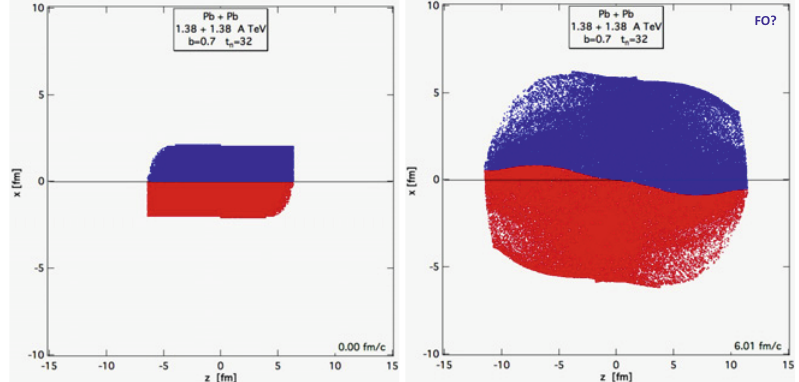
Figure 3. The fluid dynamical development of the shape of the dividing surface between the initial top and bottom halves of the dense matter. The developing non-linear, turbulent wave is the initial stage of a Kelvin Helmholtz Instability. The fluid dynamical initial state indicated by 0.00 fm / c is preceded by an pre-equilibrium Yang-Mills longitudinal field theoretical model, which took 6.25 fm / c indicated by the length of the dense matter. The configuration on the r.h.s. is at 6 fm / c fluid dynamical evolution, which is 12.25 fm / c after the initial touch of the two nuclei. This is just around the estimated freeze out time of 10-12 fm / c. Based on ref.